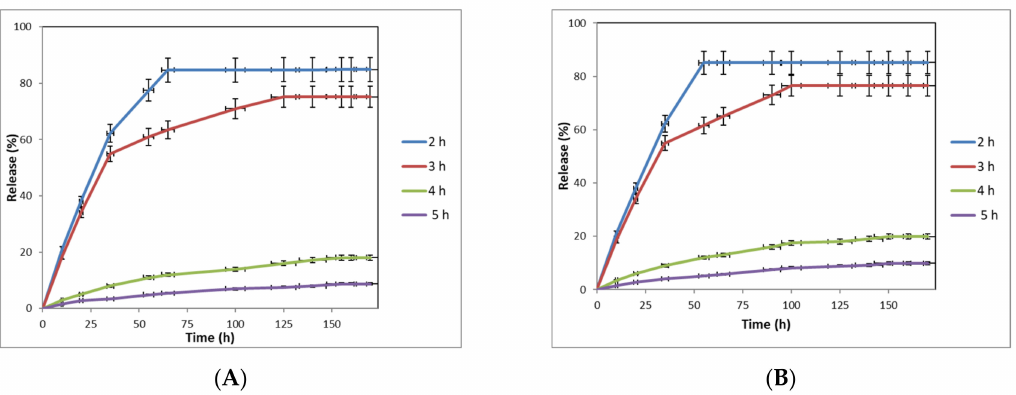
Figure 4. The release behavior of ( A ) PDDA/honey nanofiber composite (40/60) and ( B ) PDDA/honey nanofiber composite